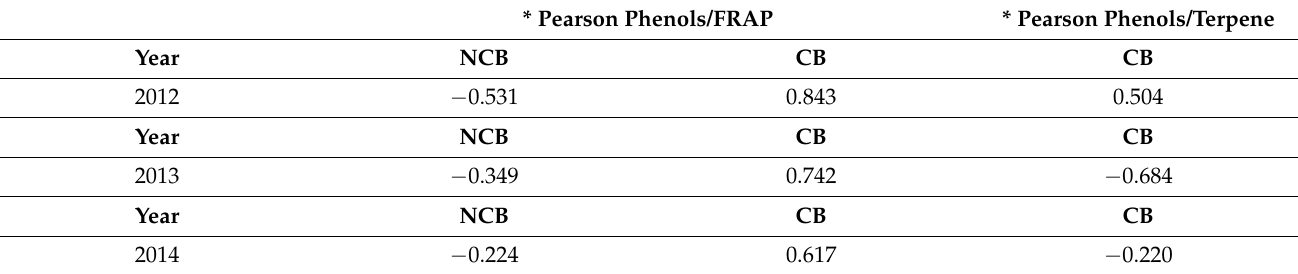
Table 3. Correlations between localities, year, phenols content, FRAP and terpene. * Pearson Phenols/FRAP * Pearson